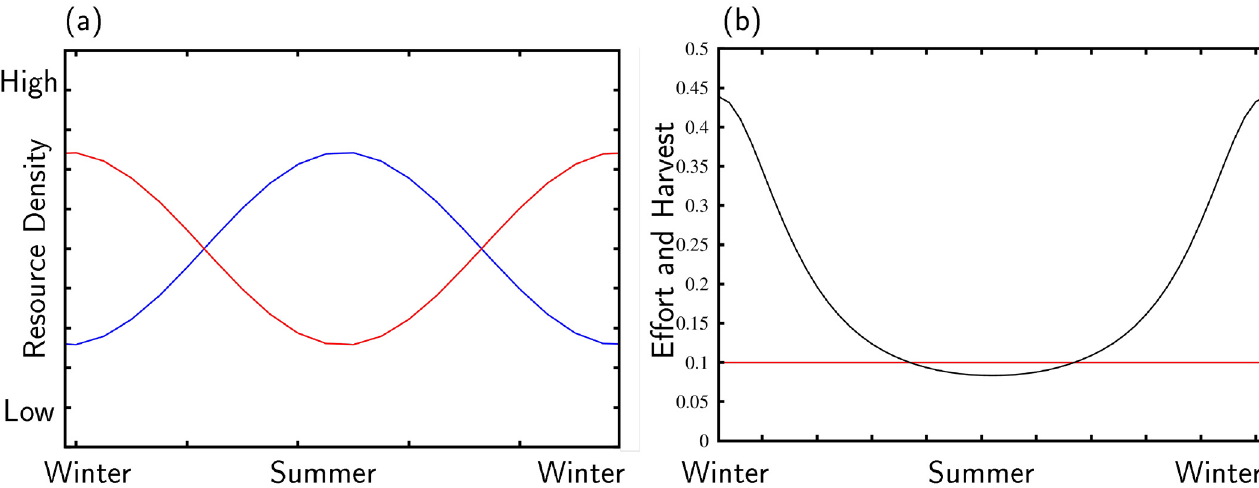
Fig 3. . Graph (a): Resource dynamics. Red curve ( x 1 ) illustrates resource variation of the TCP coast and the blue curve ( x 2 ) resource variation inland in riverine areas of the TCP. Graph (b): Harvest dynamics of a partitioned forager in the riverine area of the TCP ( x 2 ): Harvest (red curve) and foraging effort (black curve).